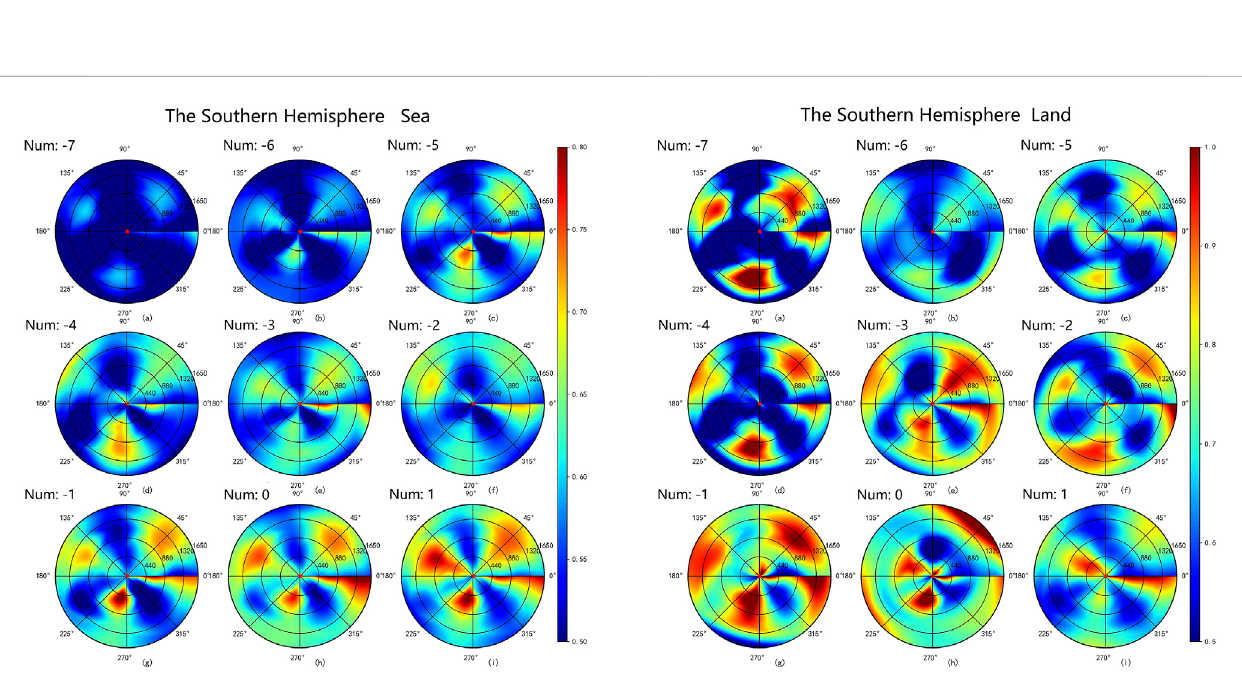
earthquake is relatively calm; From 29 days before the earthquake, the values in the earthquake preparation zones started to increase as a whole, and during the period from 24 to 20 days before the earthquake, the values within 440 km of the epicenter began to